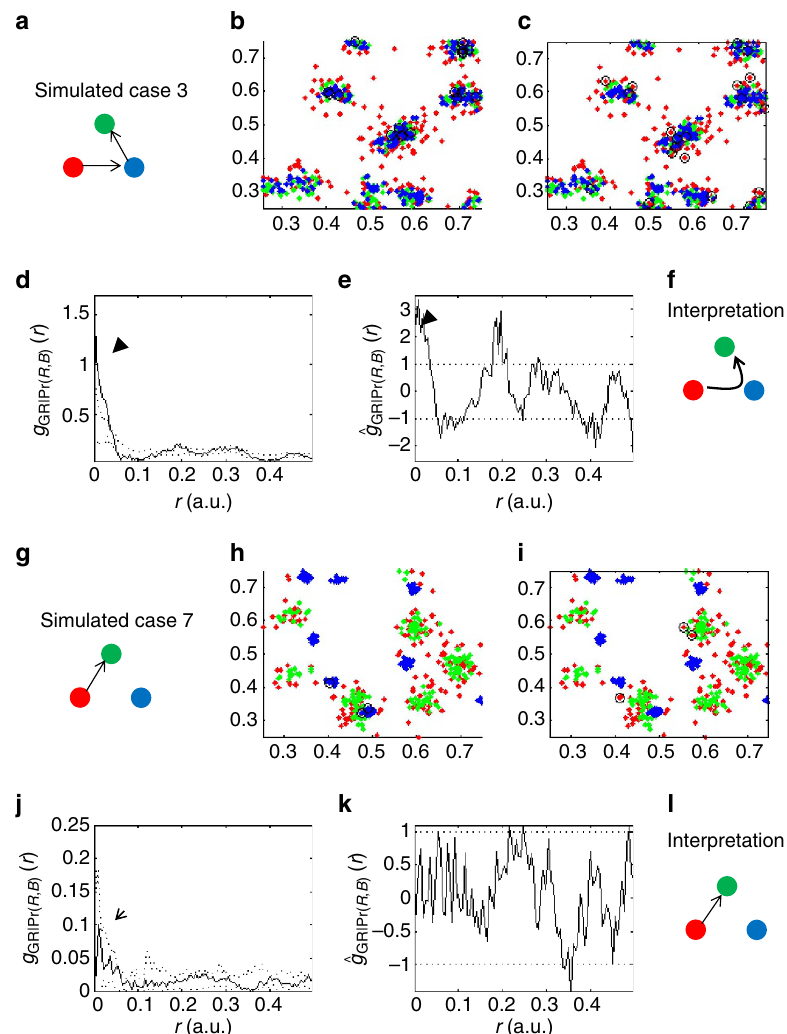
Figure 5 | The synergy analysis distinguishes synergic and non-synergic molecular interactions. ( a – f ) A case of positive interaction synergy: simulated data and interaction synergy analyses of a case depicted in a (case 3 in Supplementary Table 2). ( a ) The model of molecular interactions where red molecules (red filled circles) were recruited to blue molecules (blue filled circles) that are themselves recruited to a reference species of green molecules (green filled circles). Thus, blue molecules were ‘directly’ recruited to green molecules, while red molecules were ‘indirectly’ recruited to green molecules. ( b ) A representative simulated data ( n ¼ 20). ( c ) A representative realization of molecular clustering due to one of 19 Monte-Carlo simulations (conducted for each simulated data in b ), where red molecules were selected randomly. ( d ) The conditional bivariate PCF of the simulated data in b (see definition in equation (6) in Supplementary Information), where dotted lines mark the 95% confidence interval due to the Monte-Carlo sets (as shown in c ). Significant interaction synergy is highlighted with a black arrowhead. ( e ) The standardized conditional PCF (that is, the standardized form of the curve in d as defined in equations 7–10 in Supplementary Information). Significant interaction synergy is highlighted with a black arrowhead. ( f ) The resultant molecular interaction scheme based on the interpretation of the conditional PCFs in d , e . Synergic recruitment of red molecules to green molecules through blue molecules is marked with a curved arrow between the interacting species. ( g – l ) An example of a case of no interaction synergy: Simulated data and interaction synergy analyses of a case depicted in g (case 7 in Supplementary Table 2). ( g ) The model of molecular interactions, where red molecules are directly recruited to green molecules (red and green filled circle), while the positioning of blue molecules (blue filled circles) was unrelated to the red and green species (compare with scheme of a . ( h – i ) As for a – f of this figure. The straight arrow in l marks the direct recruitment of red molecules to green molecules, with no influence by blue